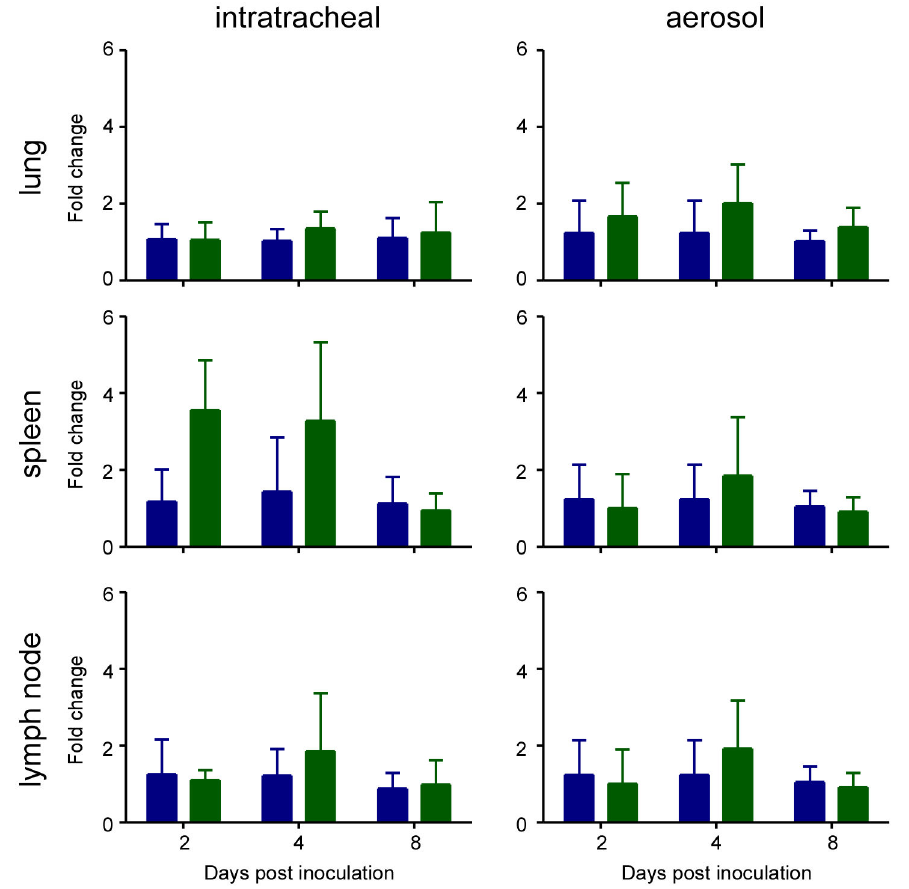
Figure 3. Mx2 gene expression in hamsters after inoculation with MERS-CoV isolate doi: